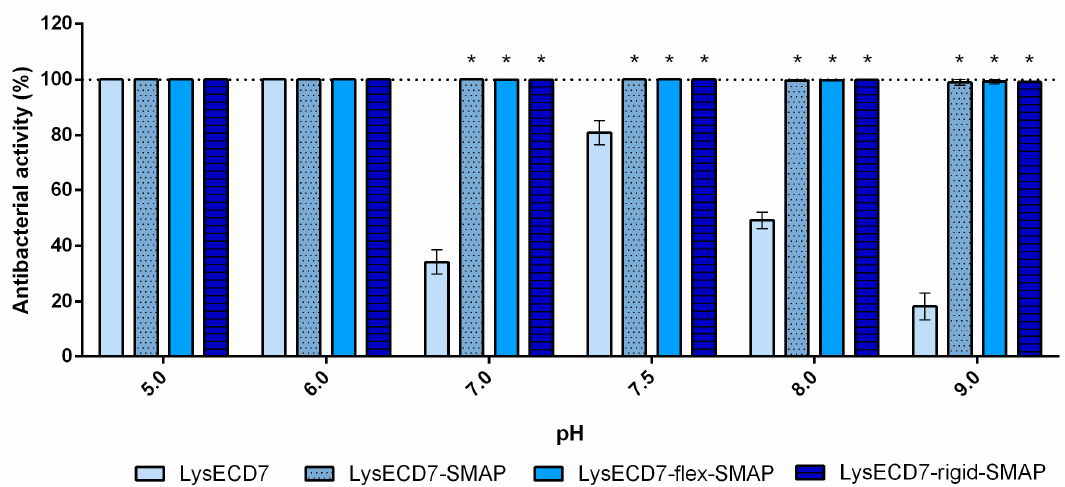
Figure 4. Bactericidal activity of SMAP-modified LysECD7 against the A. baumannii Ts 50- the pH gradient range at a protein concentration of 0.5 µ g / mL. The bacterial suspension was diluted in 16 strain over the pH gradient range at a protein concentration of 0.5 µg/mL. The bacterial 20 mM Tris HCl bu ff er with di ff erent pH values (5.0 to 9.0) to 1 to 3 × 10 5 CFU / mL and mixed with suspension was diluted in 20 mM Tris HCl buffer with different pH values (5.0 to 9.0) to 1 the proteins. For all experiments, the mean values are shown from three independent experiments ± to 3 х 10 5 CFU/mL and mixed with the proteins. For all experiments, the mean values are SD. An asterisk (*) indicates a significant di ff erence in bactericidal activity compared to the LysECD7 shown from three independent experiments ± SD. An asterisk (*) indicates a significant enzyme ( p < 0.05, two-way ANOVA with Dunnett’s multiple comparisons difference in bactericidal activity compared to the LysECD7 enzyme ( p < 0.05, two-way ANOVA with Dunnett’s multiple comparisons test).